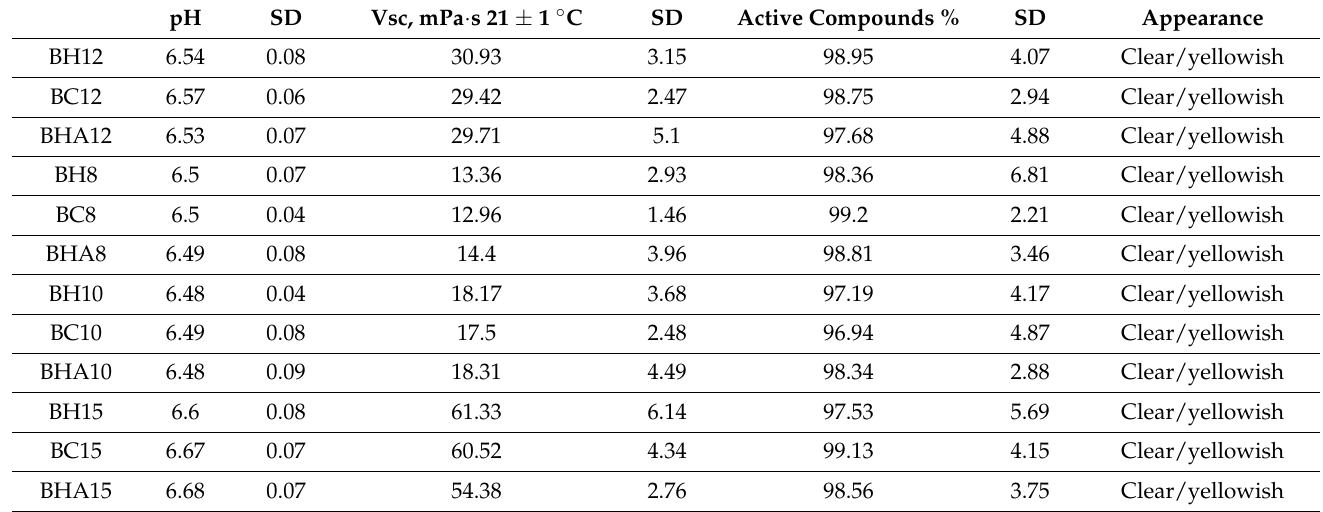
Table 4. Physicochemical properties of ophthalmic gels formulations after 30 days (mean, SD, n =